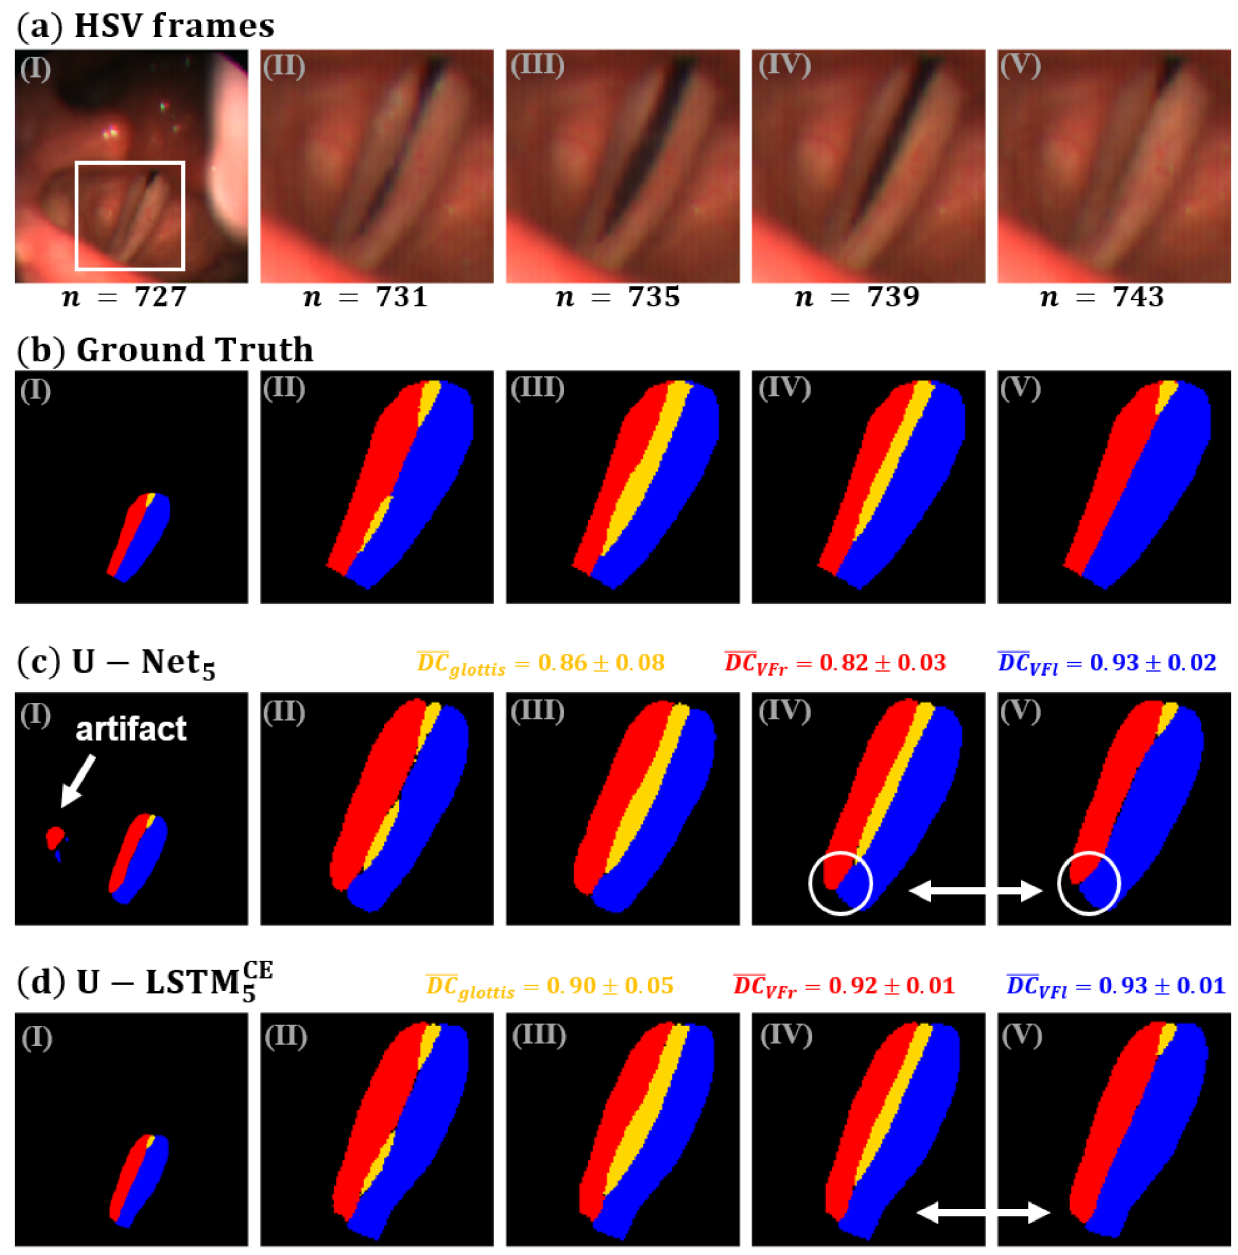
Fig 5. Comparison of segmentation results of individual images within a single subject. (a) Images of test dataset, (b) Ground Truth, (c) U-Net segmentation, (d) U-LSTM segmentation. The Dice Coefficients given for each class represent the mean and standard deviation of the entire sequence.